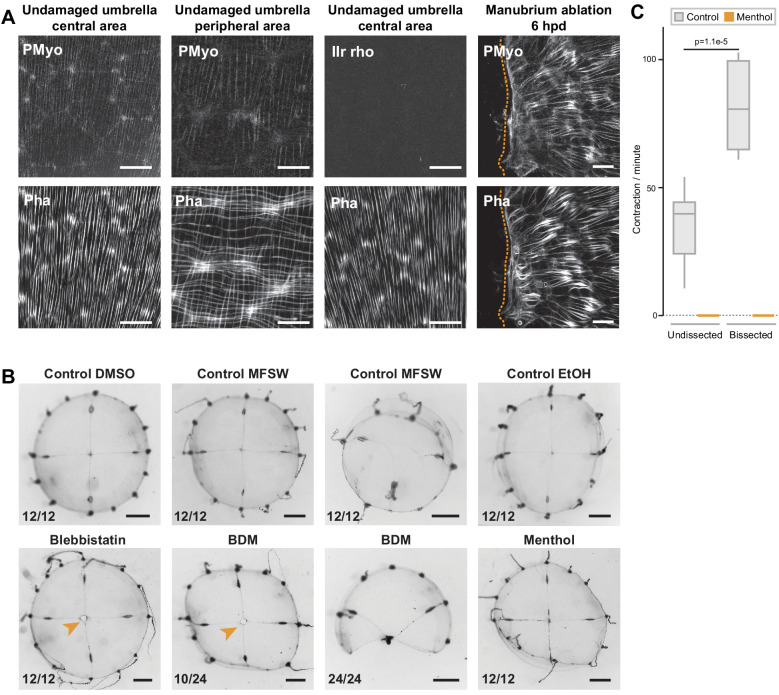
Actomyosin-driven subumbrella remodeling restores medusa shape.(A) Anti phospho-Myosin Light Chain 2 (Ser19) antibody (here indicated as PMyo) staining (upper row) of intact and remodeling muscle fibers, visualized by phalloidin staining (bottom row). PMyo antibody decorated radial smooth muscle fibers (central and peripheral umbrella), but not the circular striated muscle fibers (peripheral umbrella only). A negative control with only the secondary antibody (IIr rho) shows no staining in the smooth muscle fibers of an undamaged jellyfish. Disorganizing muscle fibers close to the wound (6 hpd) show strong myosin phosphorylation (right panel). (B) Manubrium-ablated jellyfish were incubated in different drugs (see Materials and methods), and observed 24 hpd. Controls treated in parallel with the carrier solvents (DMSO, ethanol) in FASW are shown in the top row. Jellyfish incubated in myosin inhibitors (blebbistatin and BDM) show impaired wound healing and remodeling, while inhibition of muscle contraction with menthol had no major effect. Stereomicroscope images. Scale bars: A: 1 mm, C: 25 µm. (C) Quantification of muscle contraction in non-dissected and bisected jellyfish in the absence (grey) and presence (orange) of menthol. Note that jellyfish contract significantly faster after amputation. Number of contractions per minutes was recorded for 5 min for 10 non-dissected and 10 newly bissected jellyfish, in control (0,04% ethanol) and menthol (400 µM in ethanol/FASW) conditions (see Figure 8—figure supplement 1—source data 1). Statistical test: Mann Whitney Wilcoxon.Figure 8—figure supplement 1—source data 1.Raw data for the plots shown in Figure 8—figure supplement 1C.